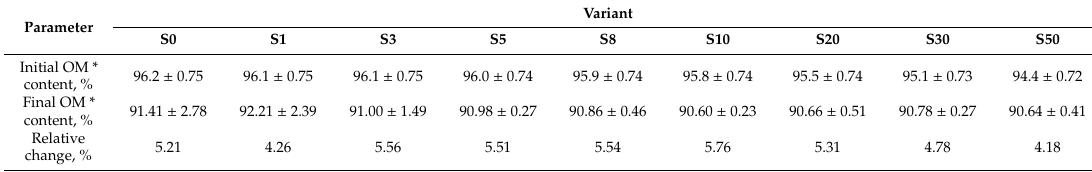
Table 3. Organic matter content reduction due to anaerobic